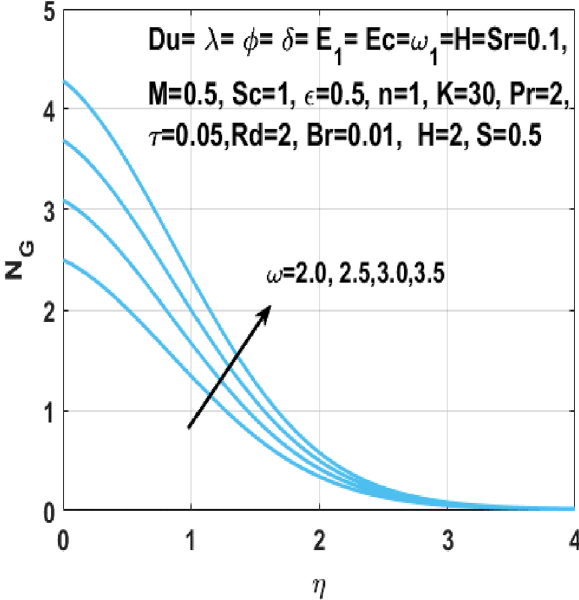
Figure 20. Impact of ω on N G .